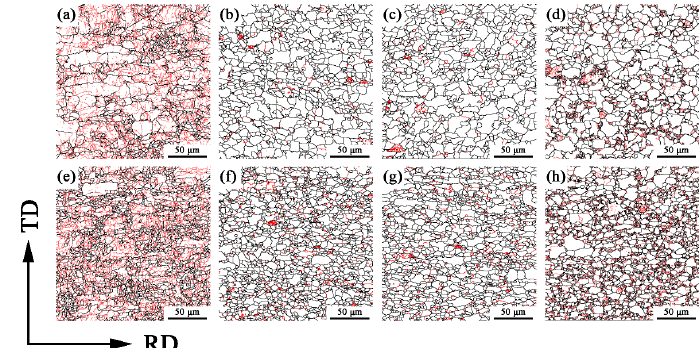
Figure 10. Grain boundary characteristic distribution of X2CrNi12 steel at 50% deformation ( a – d ) and 90% deformation ( e – h ) with different annealing temperatures, ( a , e ) deformed; ( b , f ) 720 °C; ( c , g ) 740 °C; ( d , h ) 770 °C. (The red and black lines represent LAGBs and HAGBs, respectively.). Materials 2022 , 15 , 6914